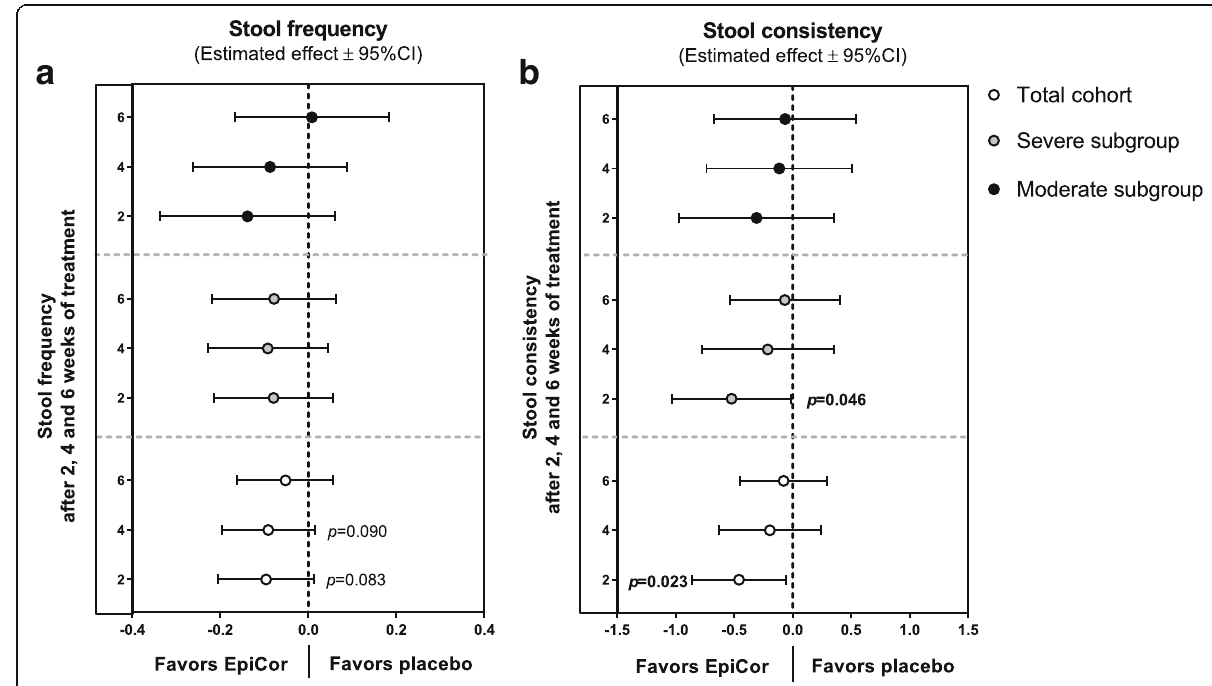
Fig. 4 Mean differences between EpiCor and placebo on stool frequency ( a ) and consistency ( b ) on the three cohorts. Legend: A linear mixed model analysis that takes into account the differences between groups at baseline was used ( p -values <0.05 are depicted in bold text; p -values <0.1 are depicted in regular